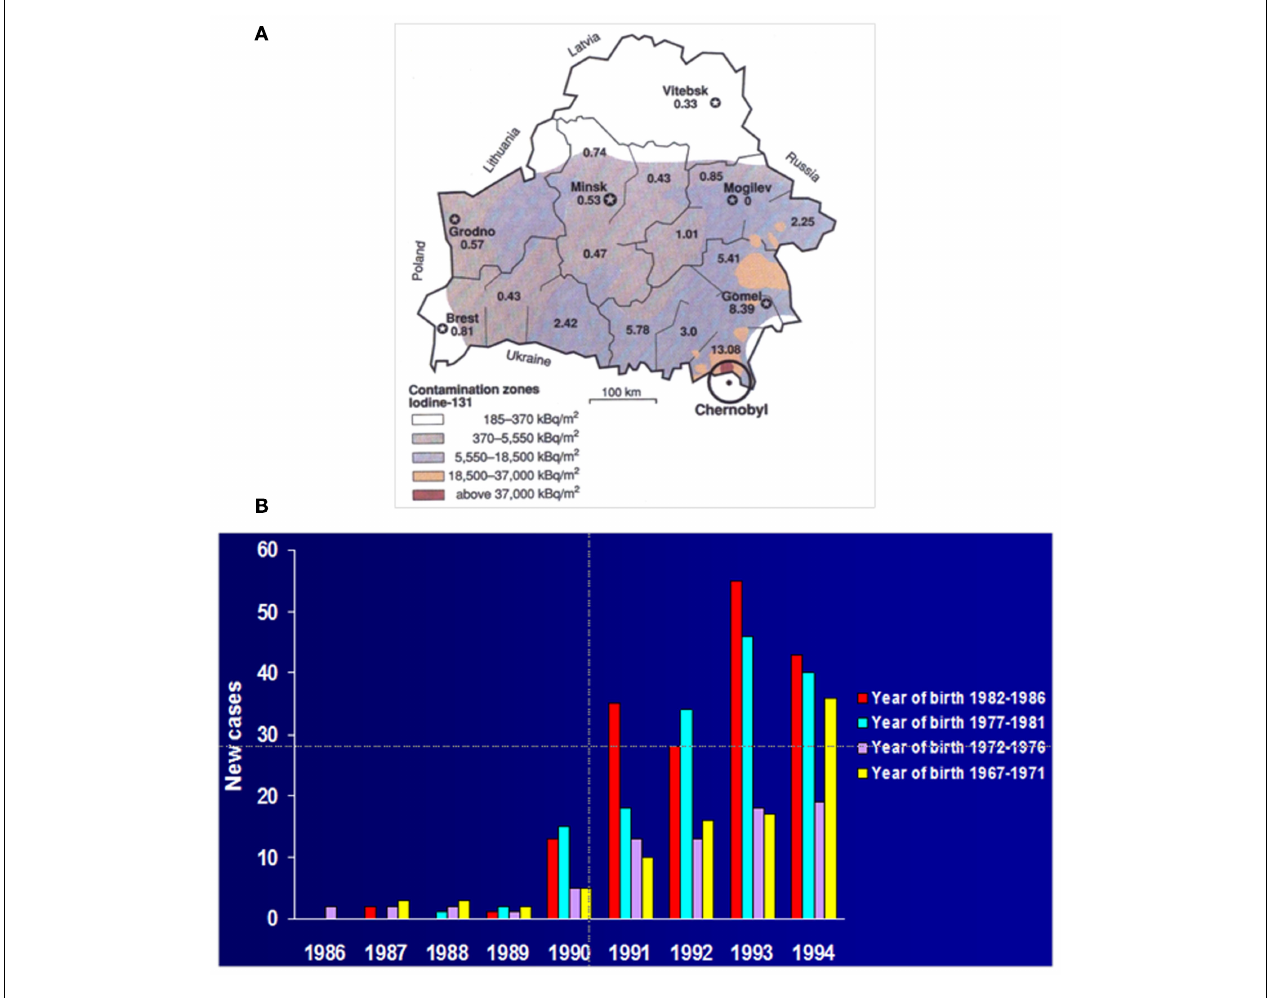
districts of Belarus, reported as number of cases per 100,000 children) [From Balter (1996) with permission of the American Association for the Advancement of Science]. (B) Unexpectedly, after the accident a rise of pediatric thyroid carcinomas was observed in Belarus with a latency as short as 4 years.The highest price was payed by the younger children at the time of the disaster [modified from Bleuer et al. (1997) with permission of Alphamed Press,